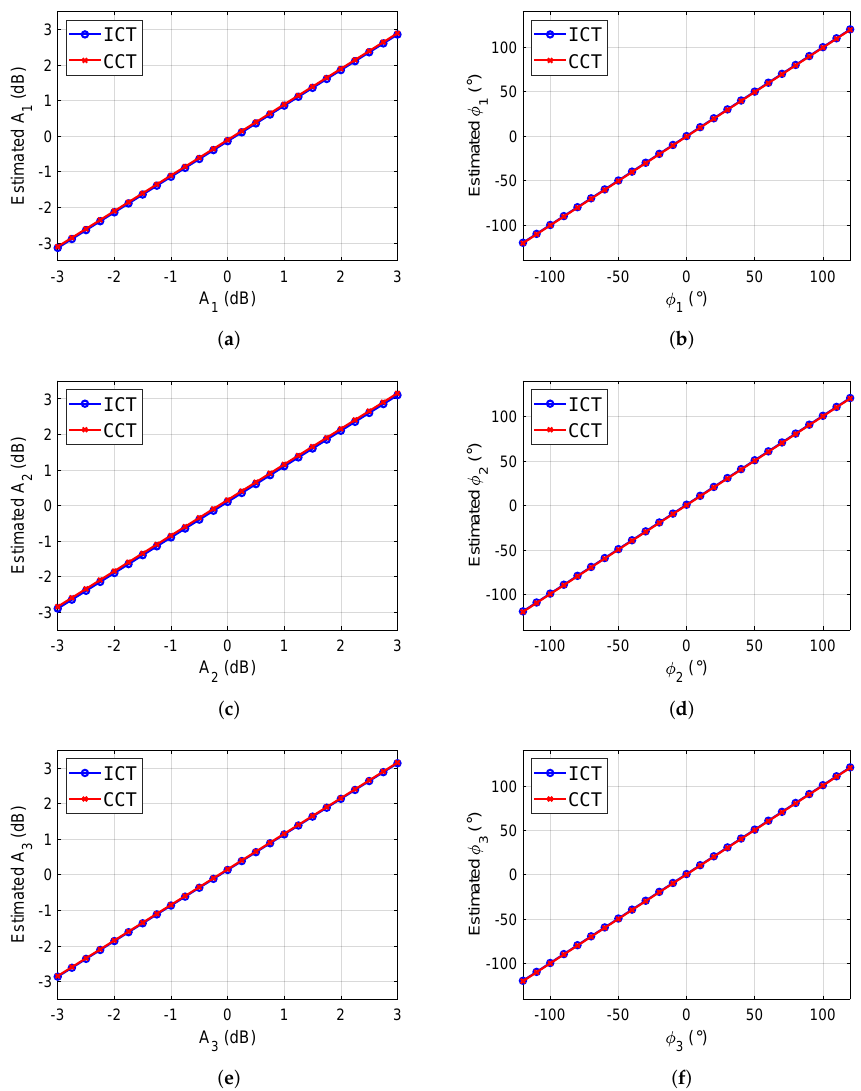
Figure 8. Simulation of amplitude and phase coefficients estimation. ( a ) | A 1 | (dB). ( b ) φ 1 ( ◦ ) . ( c ) | A 2 | (dB). ( d ) φ 2 ( ◦ ) . ( e ) | A 3 | (dB). ( f ) φ 3 ( ◦ )